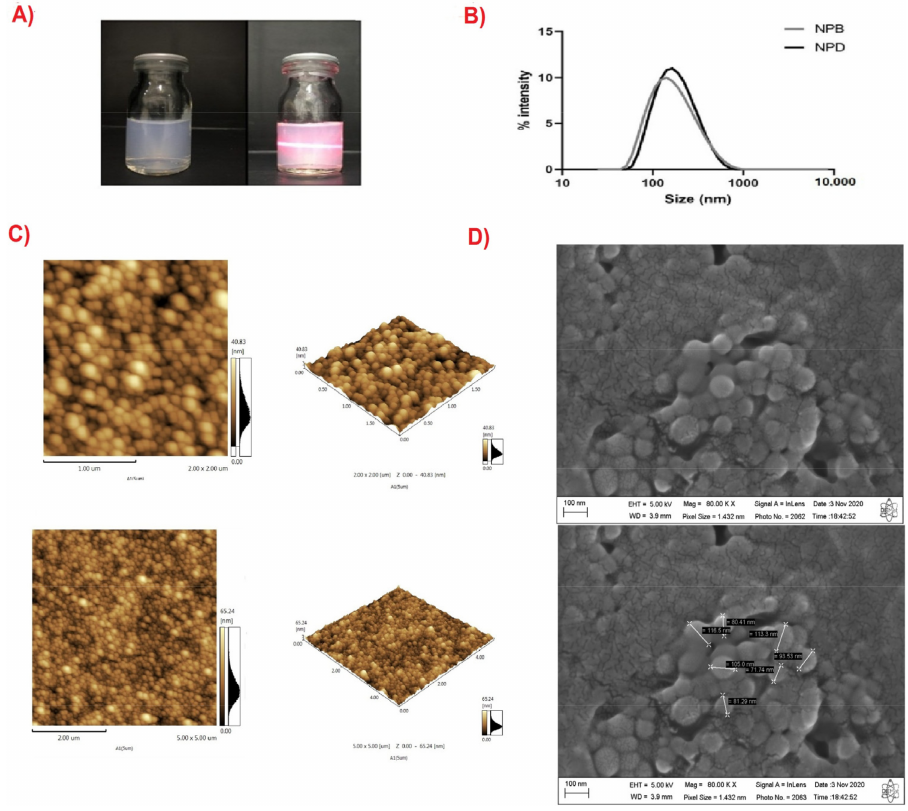
Figure 1. DETC-loaded nanoparticles. ( A ) The red-light scattering highlights the “Tyndall effect”. ( B ) Particle size intensity distribution graph of DETC-loaded nanoparticles and drug-free nanoparti- cles. ( C ) Atomic force microscopy analysis of drug-free and DETC-loaded nanoparticles. ( D ) Scanning electron microscopy analysis of drug-free and DETC-loaded nanoparticles. Table 1. Physically linked properties of the blank (NPB) and DETC-loaded nanoparticles (NPD). Results presented as mean ± standard deviation in an independent triplicate